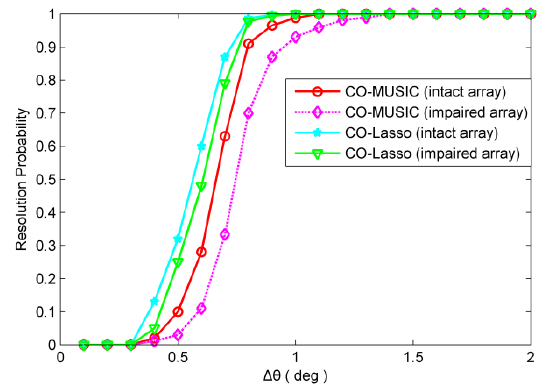
Figure 8. The scenario of redundant sensor failures, resolution probability versus θ . Two sources are set to θ 1 = 30 and θ 2 = θ 1 + θ . The snapshot number is 300 with SNR = 0 dB.